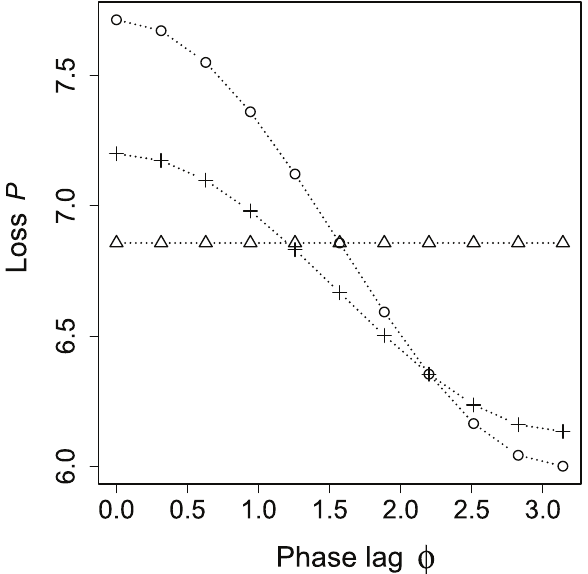
Figure 11. Relation between loss P and of small network. Circles, triangles, and crosses respectively denote Y-shaped network (Fig. 8 G ), V-shaped network (Fig. 8 H ), and complete mesh (Fig. 8 A ). The total volume (=cost) for each network is normalized by that for the complete mesh so that the three networks are made with the same cost.